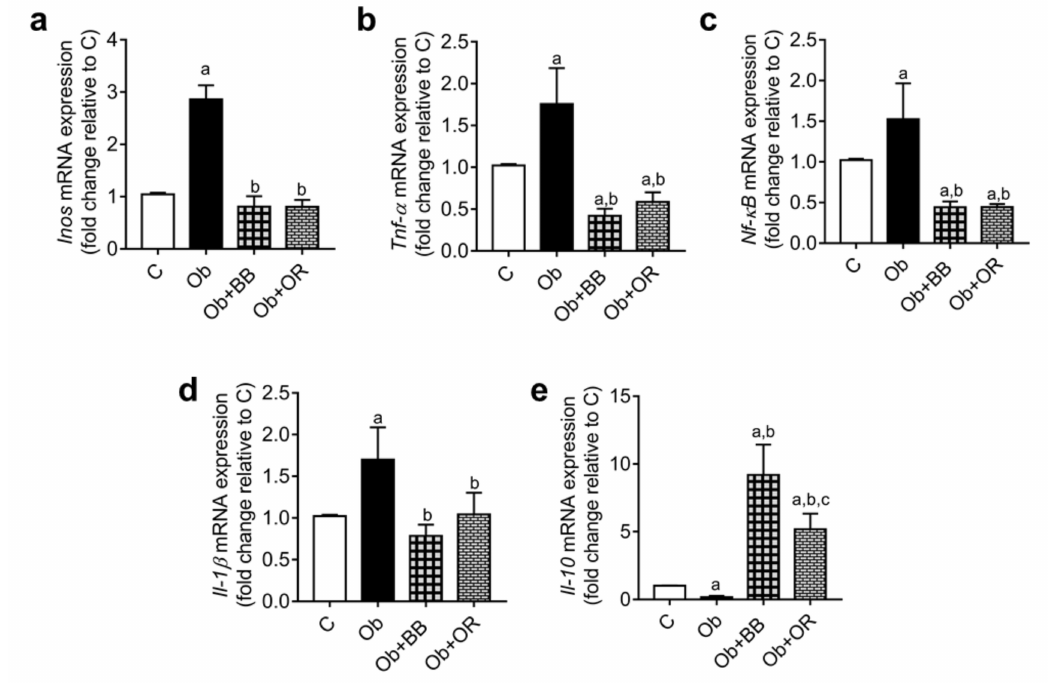
Figure 3. Effects of bee bread on the mRNA levels of inflammatory markers; ( a ) Inos , ( b ) Tnf- α , ( c ) Nf- κ B , ( d ) Il-1 β and ( e ) Il-10 in the testes of obese rats. Inos : inducible nitric oxide synthase, Il : interleukin, Nf- κ B : nuclear factor kappa B, Tnf - α : tumour necrotic factor-alpha, C: control, Ob: obese rats, Ob + BB: obese + bee bread (6 weeks after induction of obesity), and Ob + OR: Obese +